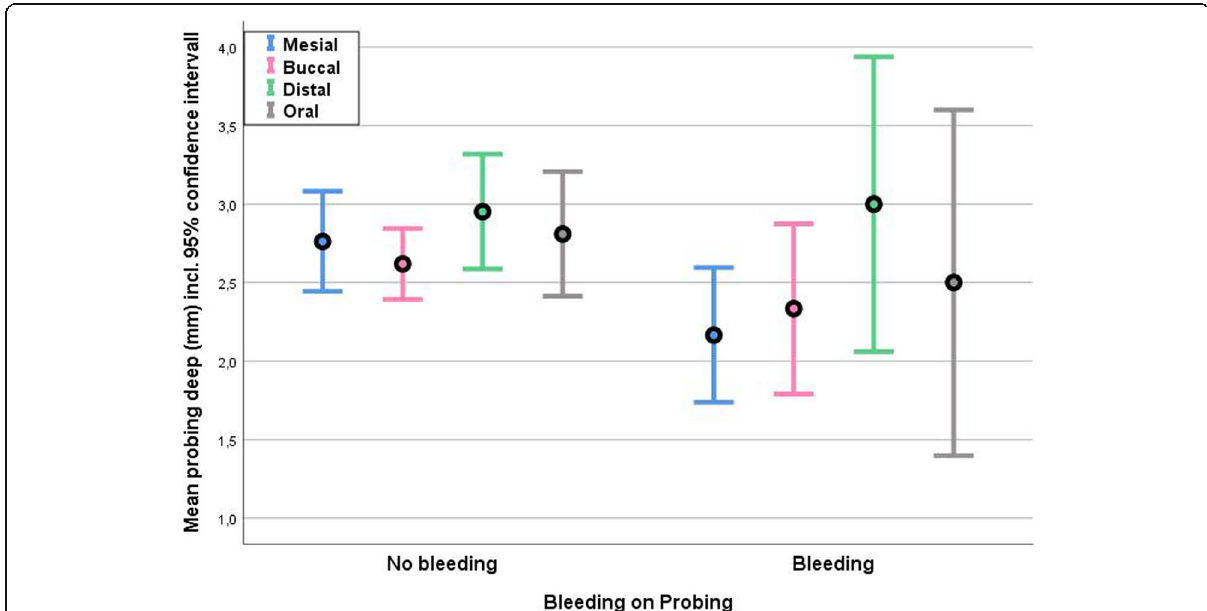
Fig. 6 correlation between mean probing depth and bleeding on probing. In the group without bleeding on probing, the deviation of measured probing depths was significantly